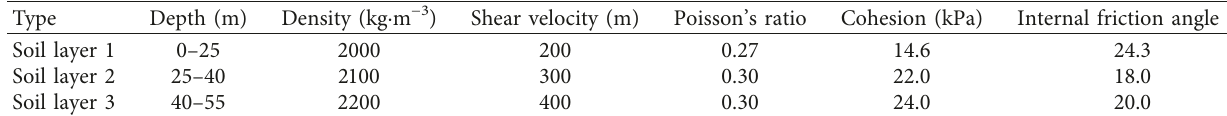
Table 3: Soil parameters.